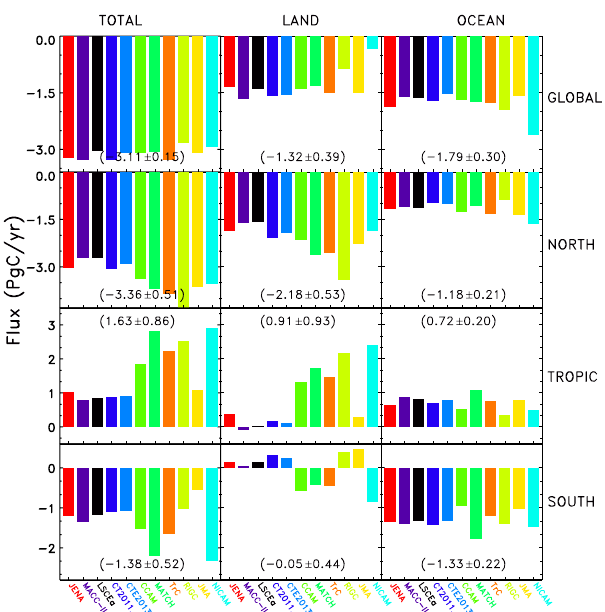
Fig. 4. Mean natural fluxes for the period 2001–2004 of the indi- vidual participating inversion posterior fluxes. Shown here are total (first column), natural “fossil-fuel-corrected” land (second column) and natural ocean (third column) carbon exchange aggregated over the Globe (top row), the North (2nd row), the Tropics (3rd row) and the South (bottom row), with the three regions divided by ap- proximately 25 ◦ N and 25 ◦ S (but modified over land areas to keep regional estimates (e.g. northern Africa) in one region; see Fig. S7 in Supplement). Numbers in parentheses represent the mean flux and the standard deviation across all